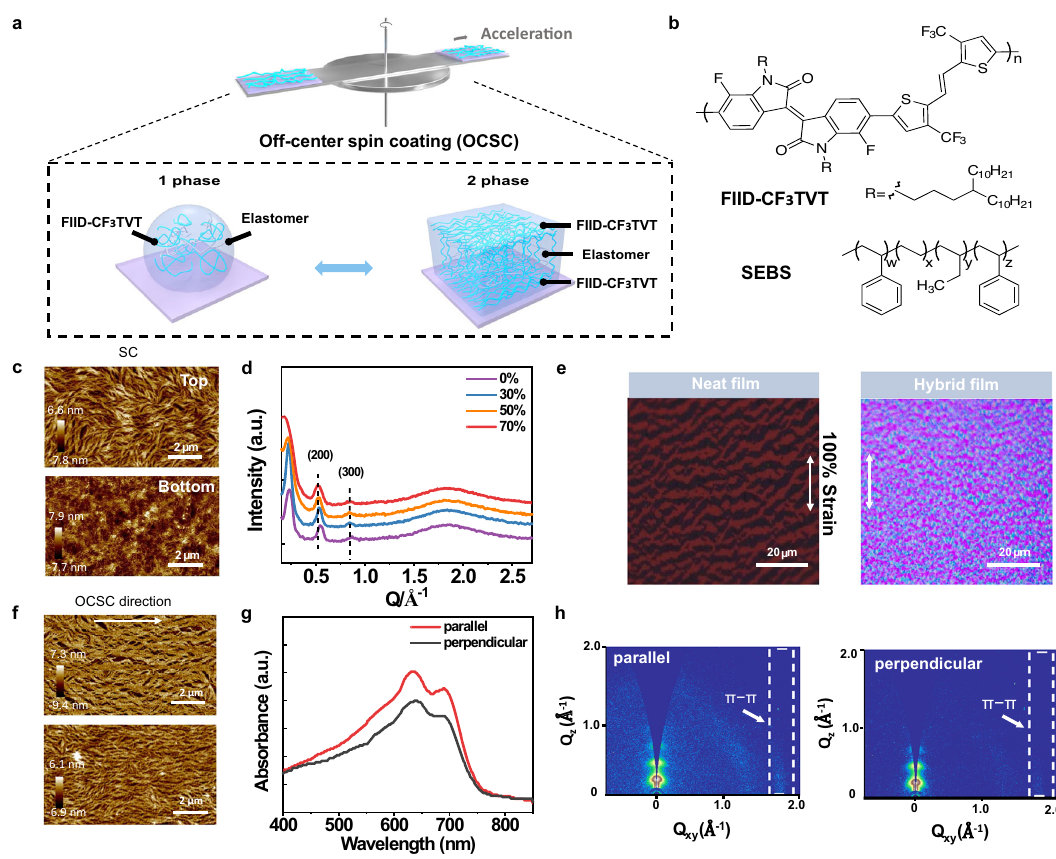
Fig. 1 | Achieving highly aligned interpenetrating polymer fi ber networks of stretchablen-typehybridpolymersemiconductor fi lmsthroughOCSCmethod combined with the spatial nanocon fi nement effect. a Three-dimensional sche- matic representation of the spatially nanocon fi ned polymer fi lm with the highly aligned interpenetrating polymer fi ber networks through the OCSC method. b Chemical structures of the polymer semiconductor FIID-CF 3 TVT and SEBS elas- tomer. c AFM height imagesofthe topand bottom surfaces of the hybrid polymer semiconductor fi lmswith70wt%SEBSthroughspin-coating(SC)method. d GIXRD line cuts for the polymer semiconductor fi lms with different SEBS contents along the Q xy axes (The lines cuts are offset for clarity). e Optical microscope images of